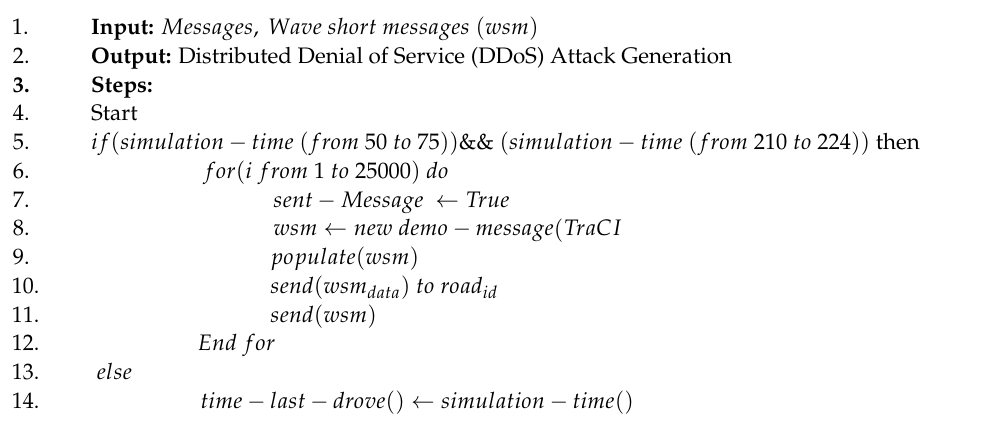
Algorithm 3: Simulations on 10% of attack density for the network environment